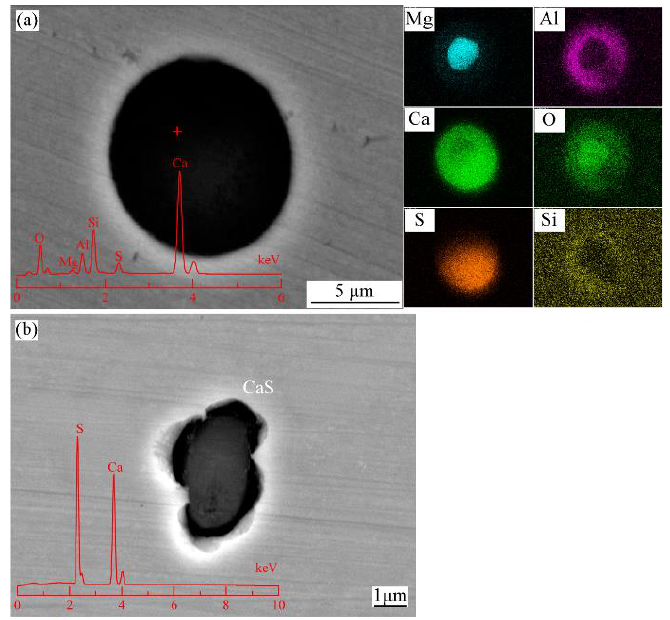
Figure 7. Morphology and element distribution of typical inclusions at tundish, ( a ) CaO-MgO-Al 2 O 3 -SiO 2 -CaS composite inclusion, ( b ) CaS.